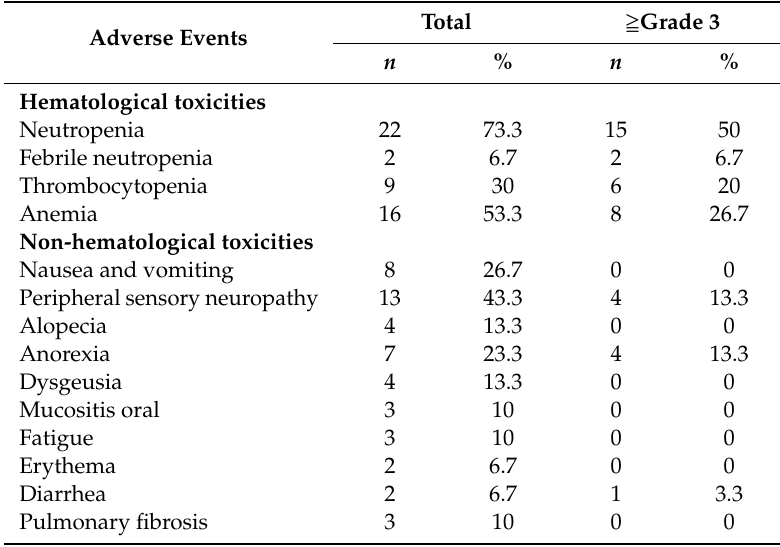
Table 5. Adverse events of patients with patients with unresectable APC treated with second-line gemcitabine plus nab-paclitaxel after failed FOLFIRINOX.